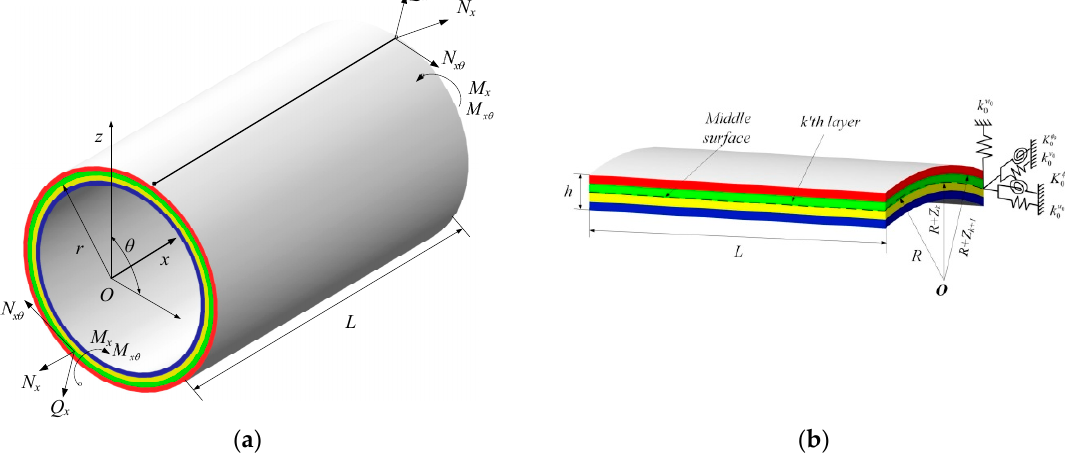
Figure 1. The schematic diagram of the moderately thick composite laminated cylindrical shell with elastic boundary conditions: ( a ) the whole composite shell; ( b ) the cross-section view of the composite shell.